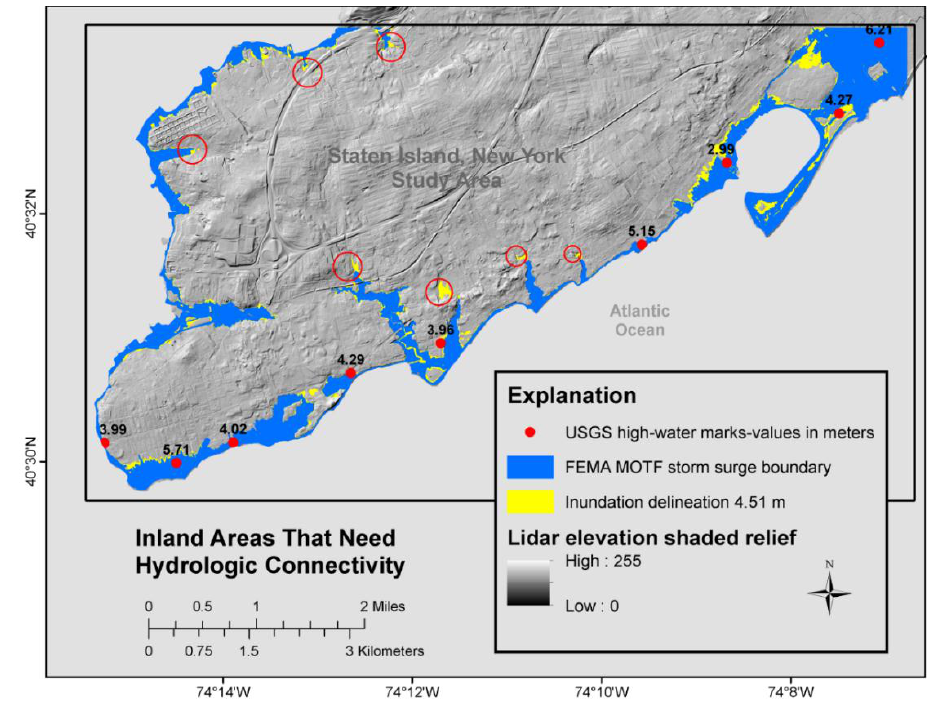
Figure 5. Comparison of the (4.51 m) inundation delineation (yellow) and the FEMA MOTF storm surge boundary (blue) overlain on a lidar elevation shaded relief. USGS high-water marks measurements (red points) are shown along with inland areas in need of hydrologic connectivity (red